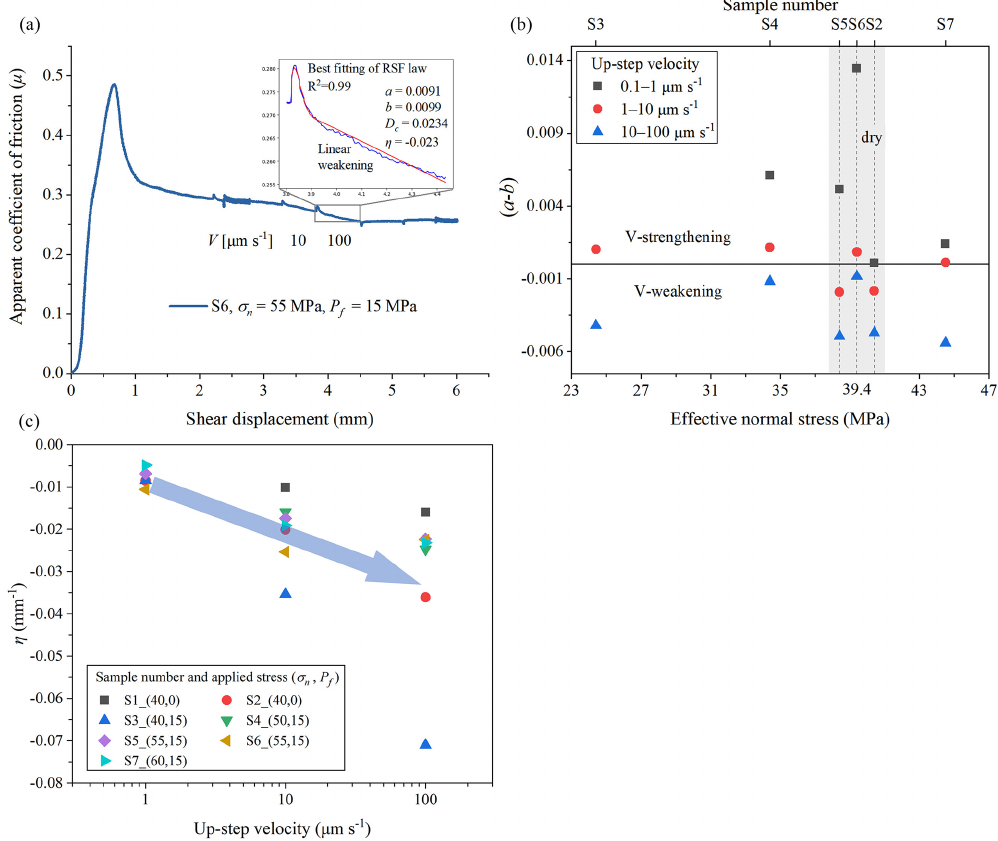
Figure 4. (a) Results of experiment S6, illustrating the best fitting of a full RSF law to the experimental data obtained at the velocity step from 10 to 100µms − 1 . (b) Values of (a − b) obtained from upward velocity steps using a full RSF fit versus effective normal stress at a linear scale. Note that the data offset is given in the grey area; i.e., the data plotted on the vertical dashed lines were all obtained at ∼ 40MPa effective normal stress but are horizontally offset here for readability. (c) The slope η of a linear slip-weakening trend versus up-step velocity in velocity stepping.